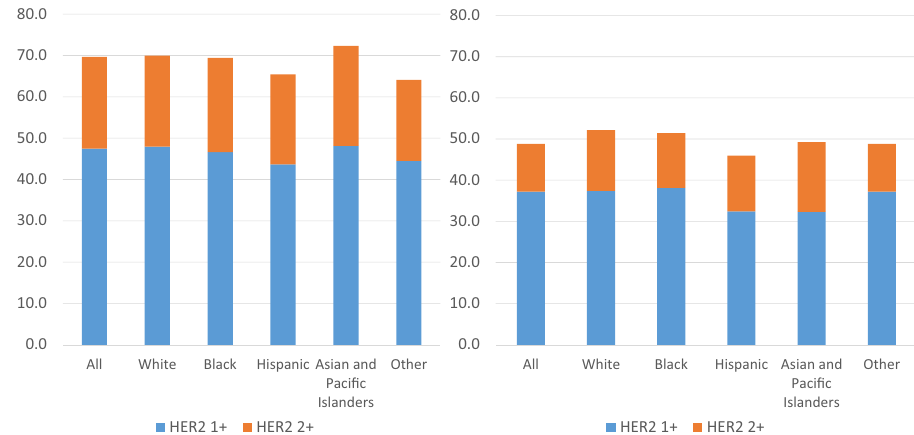
Fig. 1 Prevalence of HER2 low tumors by patient race and tumors hormonal receptor status. A (Left): Hormonal receptor positive. P < 0.001. B (Right): Hormonal receptor negative. P = 0.27; Chi-Square test was used to compare the prevalence of HER2-low disease across racial/ethinic